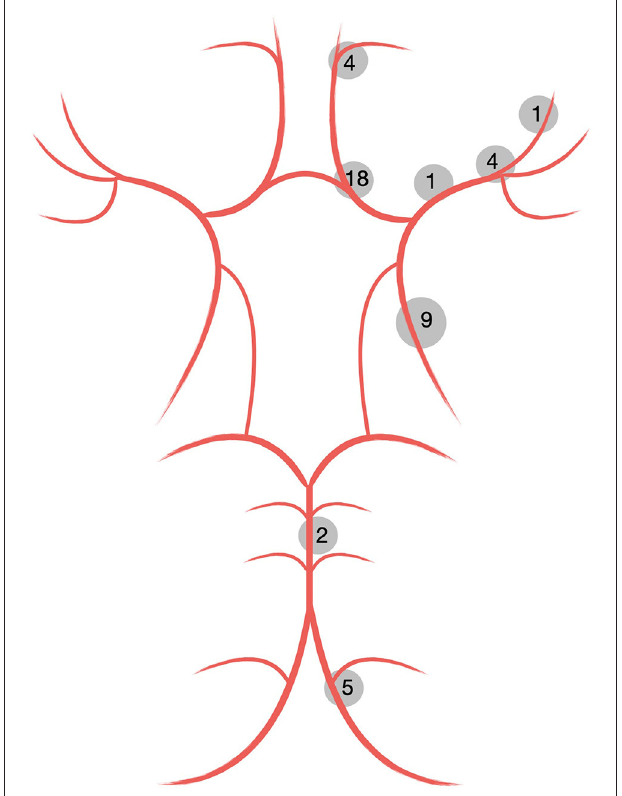
FIGURE 1 | Distribution of cerebral aneurysms treated with the